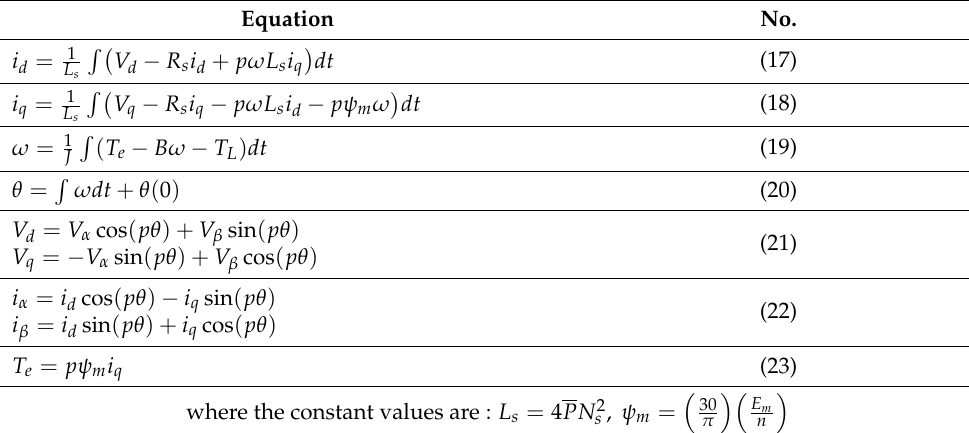
Table 1. Summarized equations for proposed Simulink model. Equation